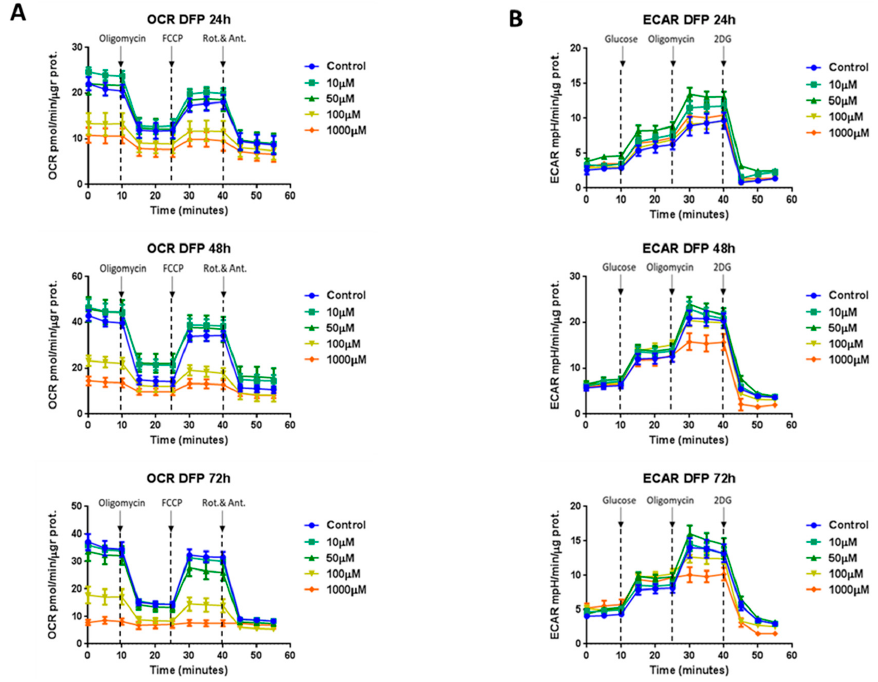
Figure 4. DFP reduces the mitochondrial and glycolytic metabolism in MCF7 cells: 24 to 72 h of treatment. (Panel A ) Note that the DFP treatment significantly inhibited the oxygen consumption (OCR) in a time-dependent and dose-dependent fashion, showing a consistent reduction in oxygen consumption already at a concentration of 100 μ M. Here are shown the 24, 48, and 72 h time points, respectively. (Panel B ) DFP treatment slightly reduced the extracellular acidification after 72 h treatment at a concentration of 1 mM. Here are shown 24, 48, and 72 h time points,